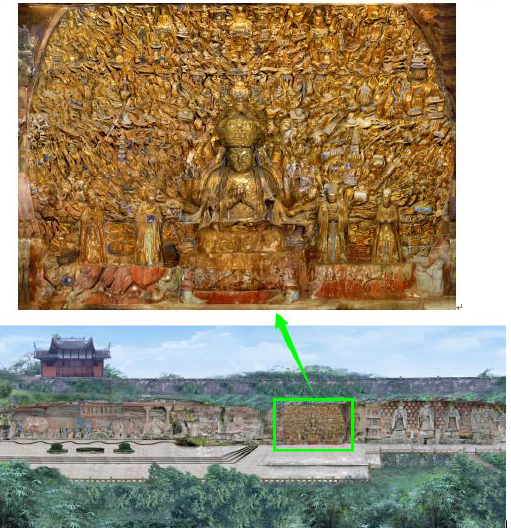
Figure 11. An ortho-photo map of the Dazu Thousand-Hand Bodhisattva Statue and a panoramic of the partial view at Giant Buddha Bay.